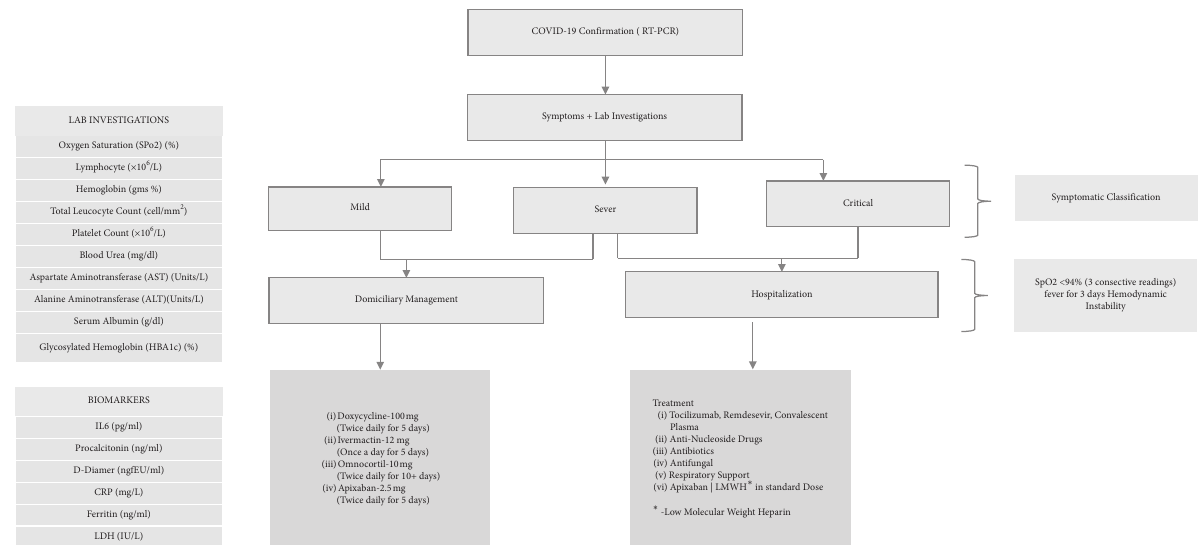
Figure 1: Schematic representation of the study in kidney transplant recipients with